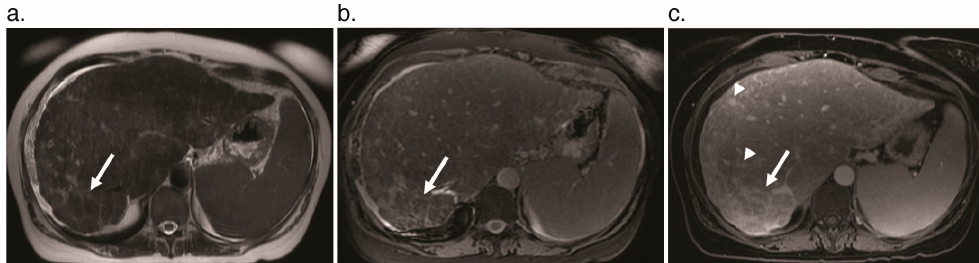
Figure 7. Chronic liver injury with nodular regenerative hyperplasia, pseudocirrhosis, and peripheral fibrosis in a 54-year-old woman with HHT. ( a ) Axial T 1 -weighted MR image shows parenchymal nodularity most prominent in the posterior right hepatic lobe (arrow). ( b ) Axial T 2 -weighted fat-saturated MR image shows a reticular pattern of increased signal in the posterior right hepatic lobe (arrow). ( c ) Delayed enhancement on the axial T 1 fat-saturated gadolinium-enhanced MR image (arrow), along with multiple telangiectases (arrowheads).